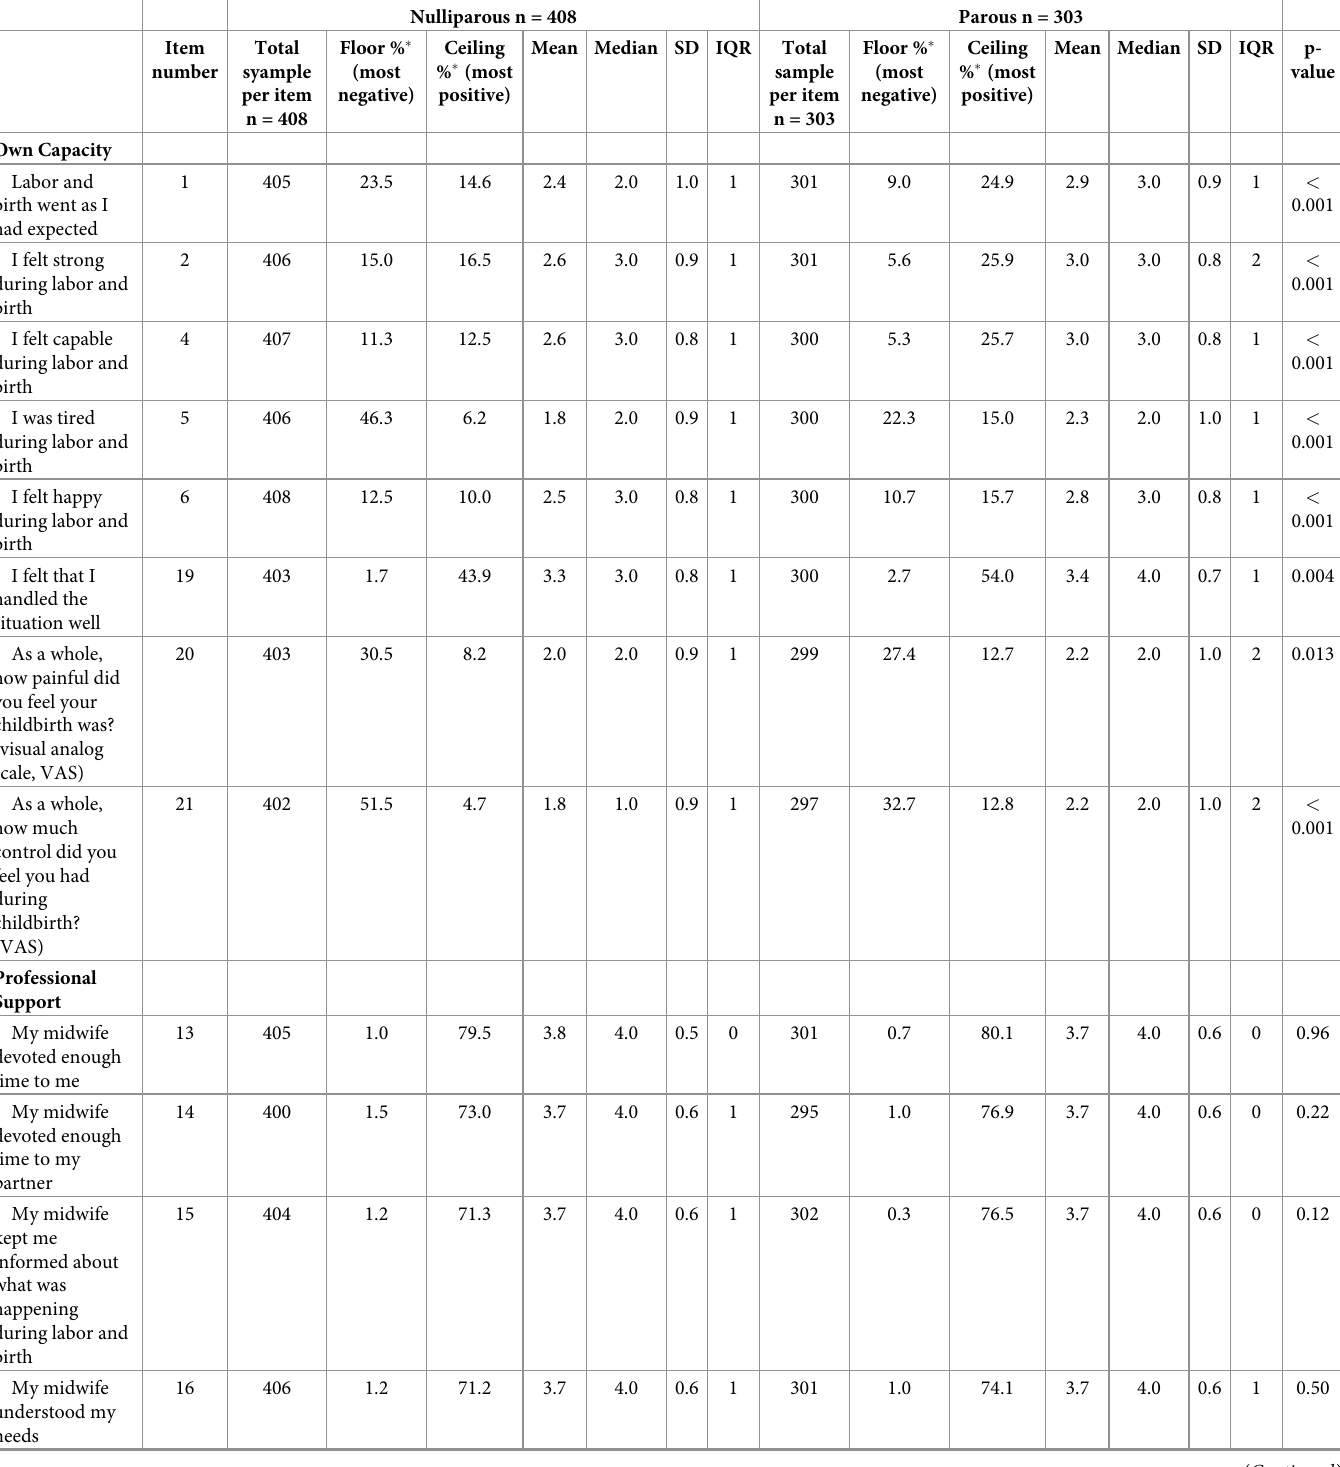
Table 4. Childbirth experience questionnaire (CEQ) item descriptions (N =